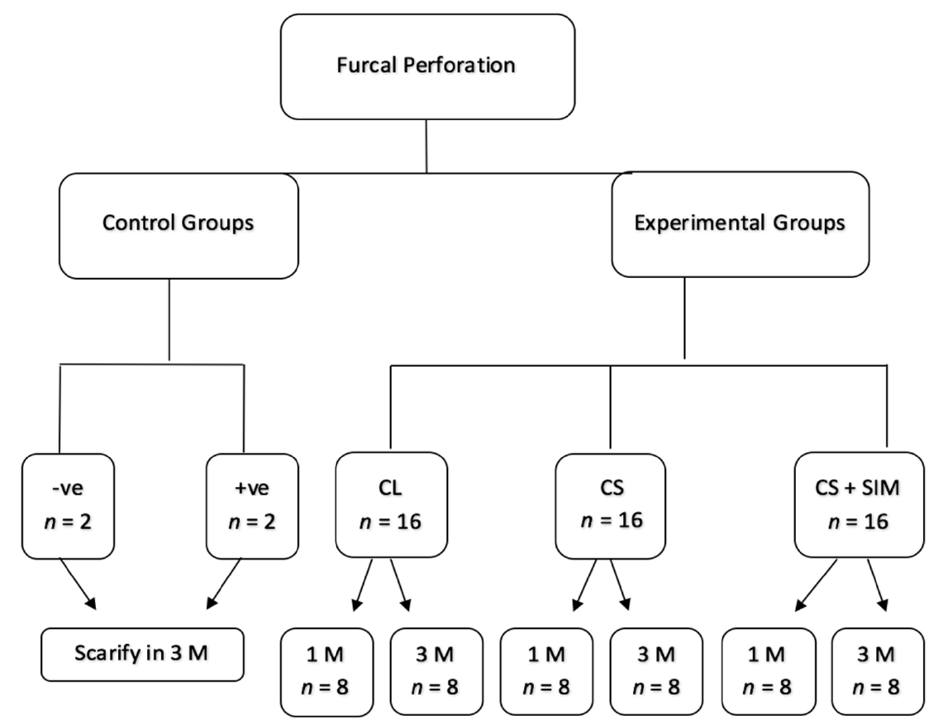
Figure 1. Group Distribution. − ve: negative; +ve: positive; CL: CollaCote; CS: Chitosan; SIM: Simvastatin; M: month.